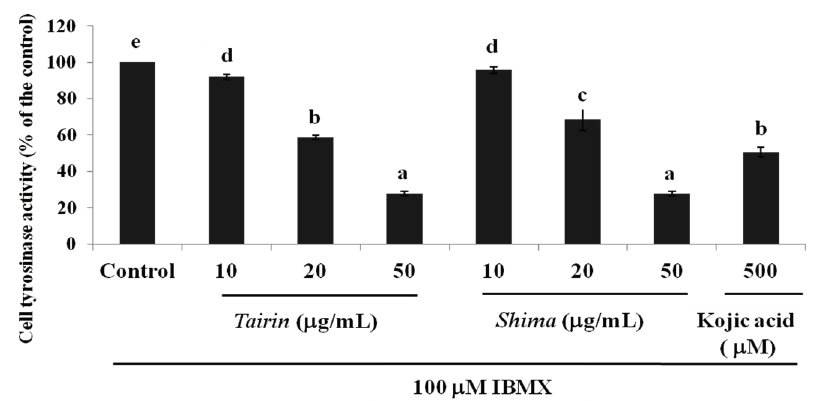
Figure 6. Effect of tairin and shima essential oils (EOs) on intracellular tyrosinase activity in B16F10 melanoma cells. B16F10 cells were treated with various concentrations of EO and incubated for 48 h. The intracellular tyrosinase activity of B16F10 melanoma cells was measured with a microplate reader at 490 nm. Values shown represent the mean ± standard error for three independent experiments. One-way ANOVA was used for the comparison of multiple group means, followed by the Duncan test ( p < 0.05). Letters with different superscripts indicate samples that are significant different ( p < 0.05) from each